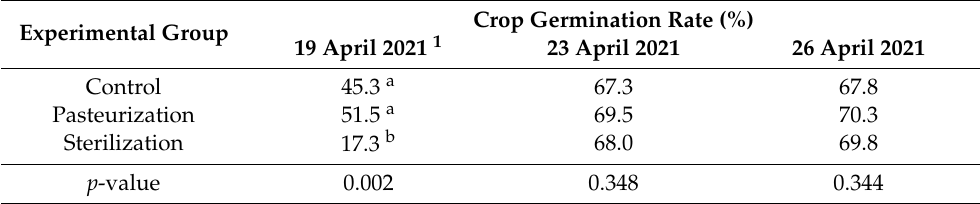
Table 8. Effects of compost treatments on the germination rate of tomato seedlings ( n = 4). Tomato seeds were planted on 12 April 2021.